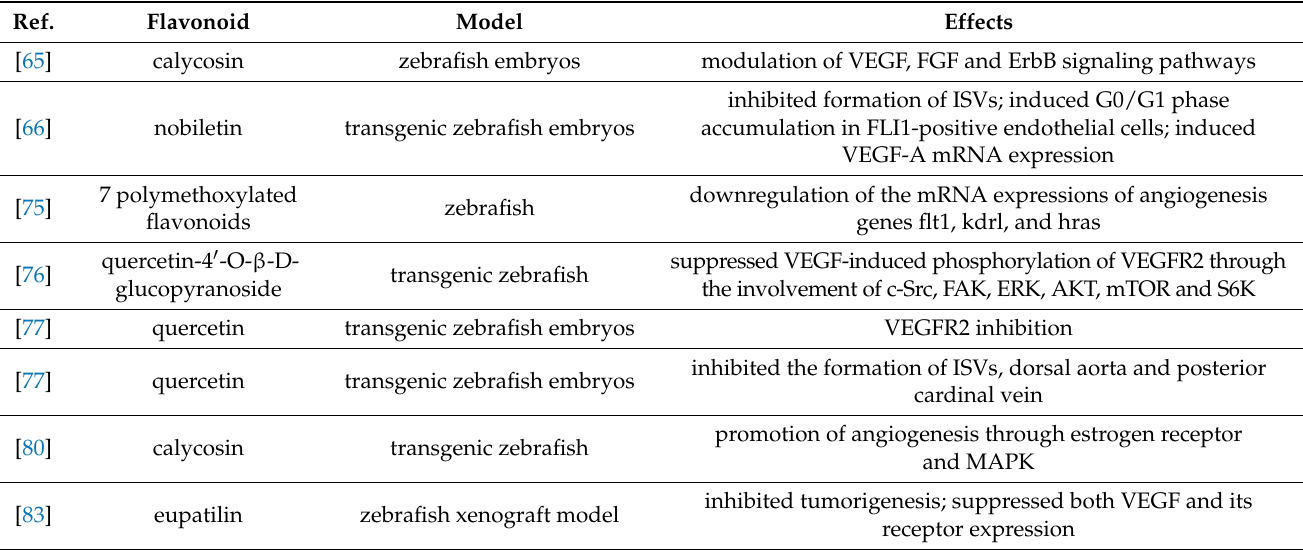
Table 2. Antiangiogenic and antitumor effects of flavonoids in zebrafish.